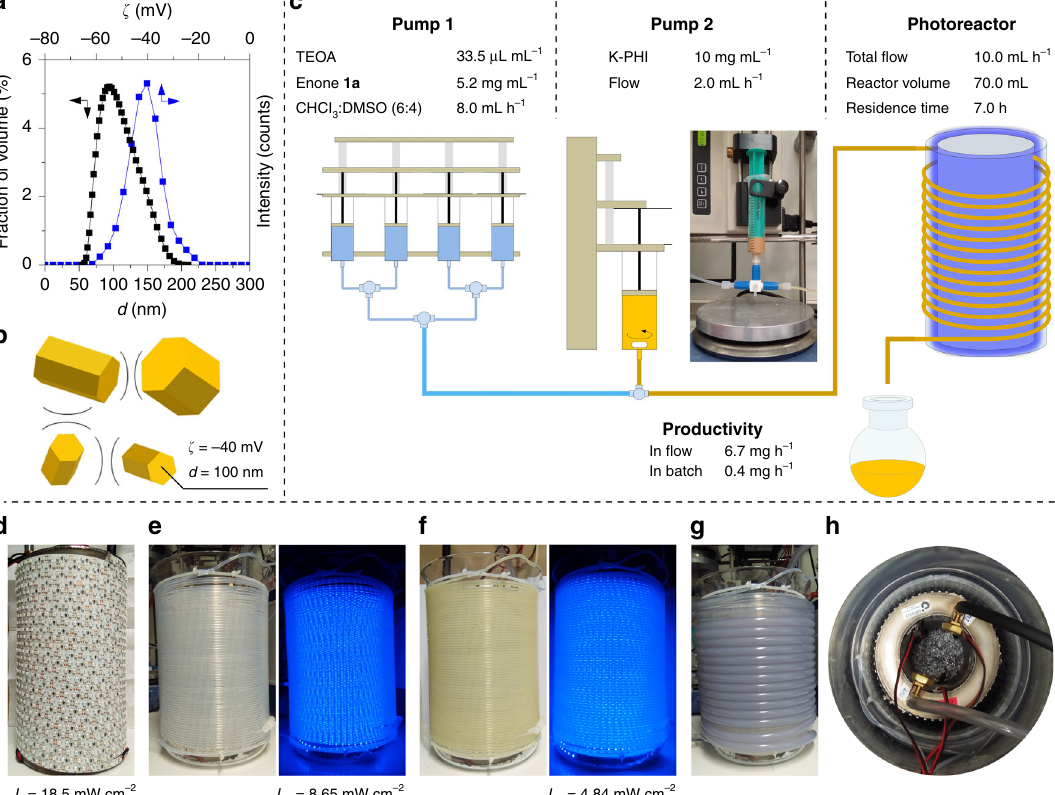
Fig. 3 K-PHI colloidal solution properties and fl ow photoreactor design used in this work. a Zeta-potential ( ζ ) and hydrodynamic diameter ( d ) of K-PHI particles suspended in water. Source data are provided as a Source Data fi le. b Schematic representation of colloidal solution stabilization by electrostatic repulsion. c Schematic representation of the reactor setup and reaction parameters. Yield was determined by GC-MS collecting the solution for 30 min from the photoreactor; comparison between fl ow and batch are made considering the optimized reaction conditions in batch. d The light source was built by wrapping self-adhesive LED stripes around a hollow steel cylinder shell equipped with inlet and outlet for water-cooling. Incident light intensity ( I 0 ) measured at zero distance from the light source 18.5 mW cm − 2 . e Light source placed inside a glass beaker wrapped with FEP tubing under day light and blue light source. Transmitted light intensity ( I T1 ) was measured at zero distance from the FEP tubing. f FEP tubing fi lled with a reaction mixture under day light and blue light source. Transmitted light intensity ( I T2 ) was measured at zero distance from the FEP tubing. g Photoreactor wrapped with PVC tubing to maintain the desired temperature during the experiment. h View from the top on the assembled fl ow photoreactor immersed into a glass beaker. The space between the beakers is fi lled with cooling agent (water).